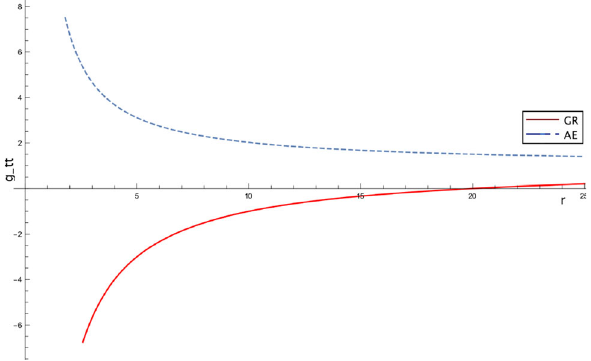
Fig. 5 Plot of the metric component g tt , for EA parameters c 14 = 48 / 25, | γ | = 1 and an arbitrary Schwarzschild mass M = 10 The continuousredlinerepresentstheGRSchwarzschildmetric.Thedashed blue line represents the EA solution. Calculating the limit r → +∞ ,